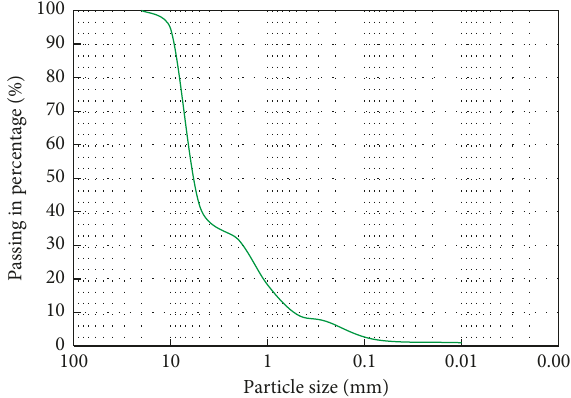
Figure 2: Particle size distribution of the